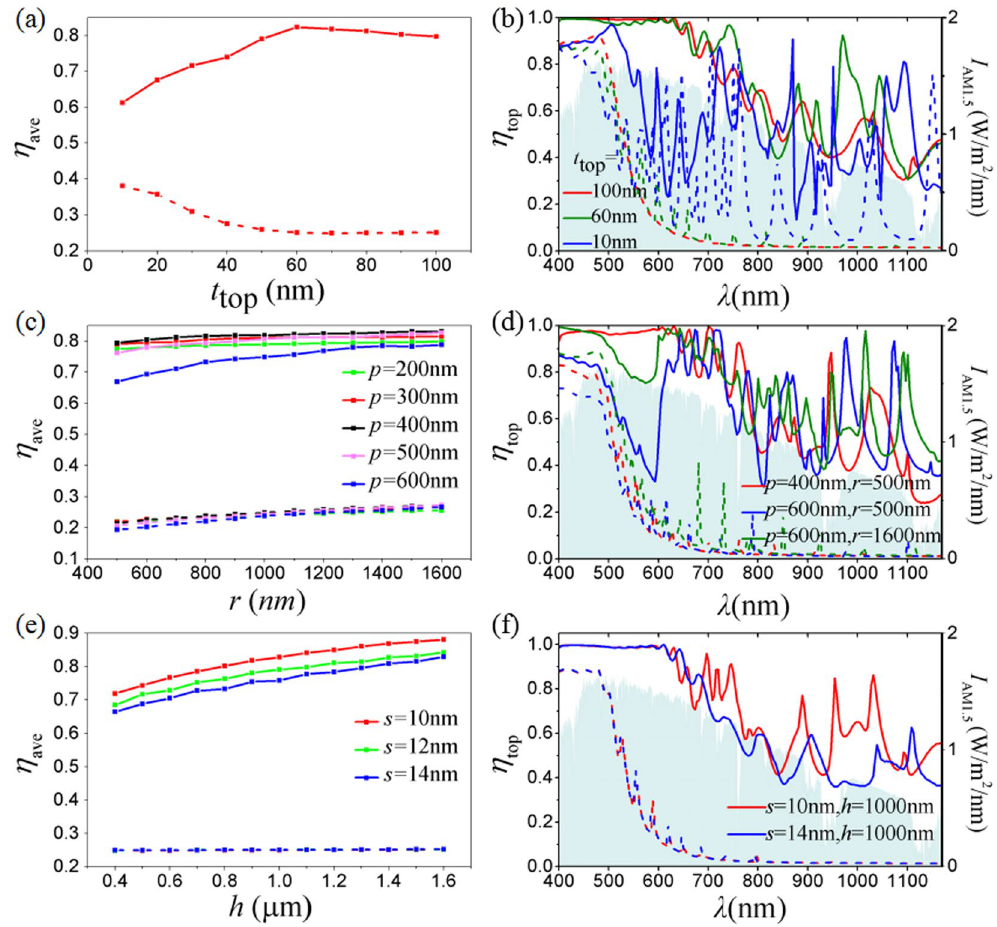
Figure 5. Averaged absorption, η ave , of our hot-carrier solar cell based on the combined structure of capped nanowires with top nanocones for both p -polarization (solid curves) and s -polarization (dotted curves) as a function of ( a ) the top Au film thickness, t top , with s = 10 nm, h = 1 μ m, r = 1 μ m, and p = 400 nm; ( c ) the circle radius to form the nanocones, r , for different period, p , with s = 10 nm, h = 1 μ m, and t top = 70 nm; ( e ) the nanoslot height, h , for different nanoslot widths, s , with r = 1 μ m, p = 400 nm, and t top = 70 nm. Some representative absorption spectra in the top Au film, η top , for both p -polarization (solid curves) and s - polarization (dotted curves) are plotted in Fig. 5(b,d,f) corresponding to η ave in Fig. 5(a,c,e), respectively. In Fig. 5(b,d,f), the solar spectral intensity is shown in all the four panels in light blue areas characterized by the right